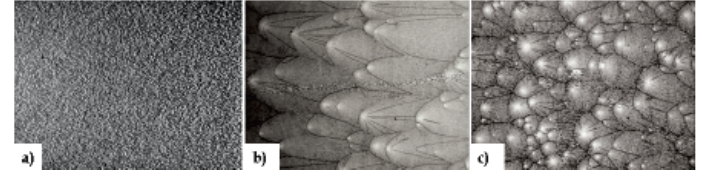
Fig. 1. Microscope images (1 . 4 × 1 mm 2 ) of the fracture surfaces, taken at : (a) v = 110 ± 10 ms − 1 , (b) v =